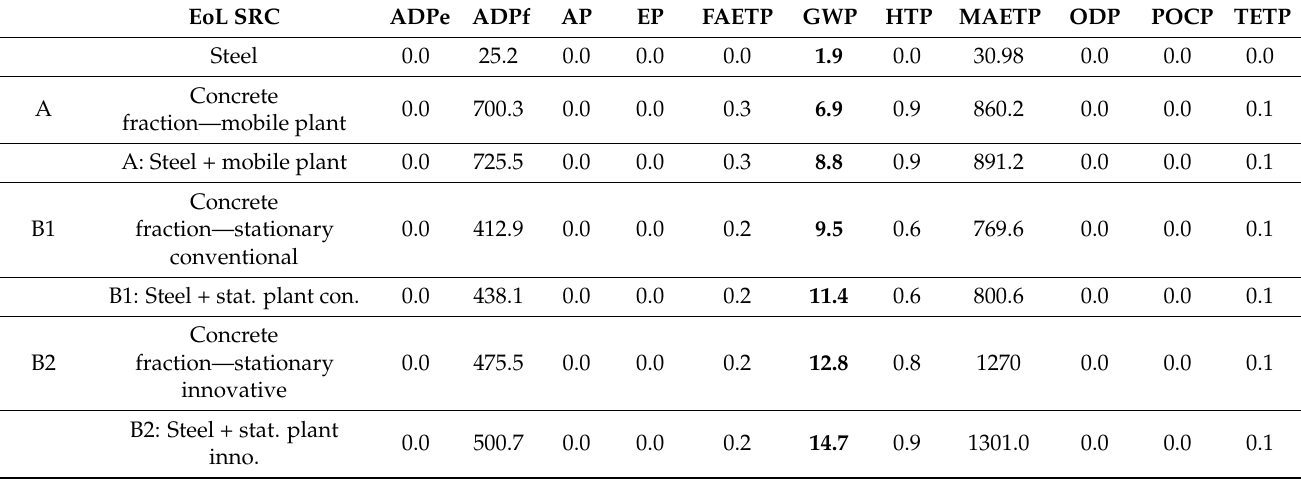
Table 3. LCA SRC-EoL CML2001.